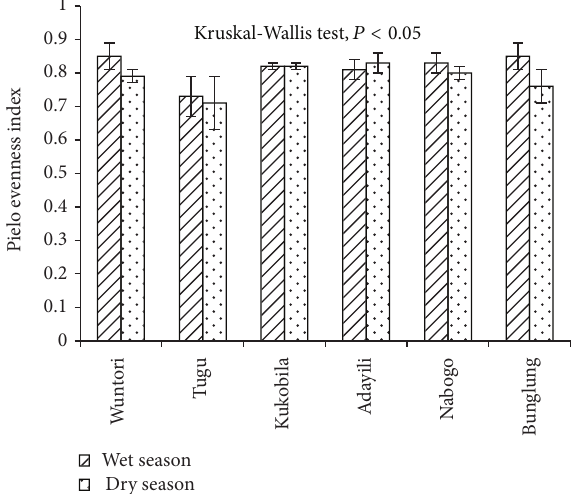
Figure 4: Bird evenness distribution of birds in the wet and dry seasons.